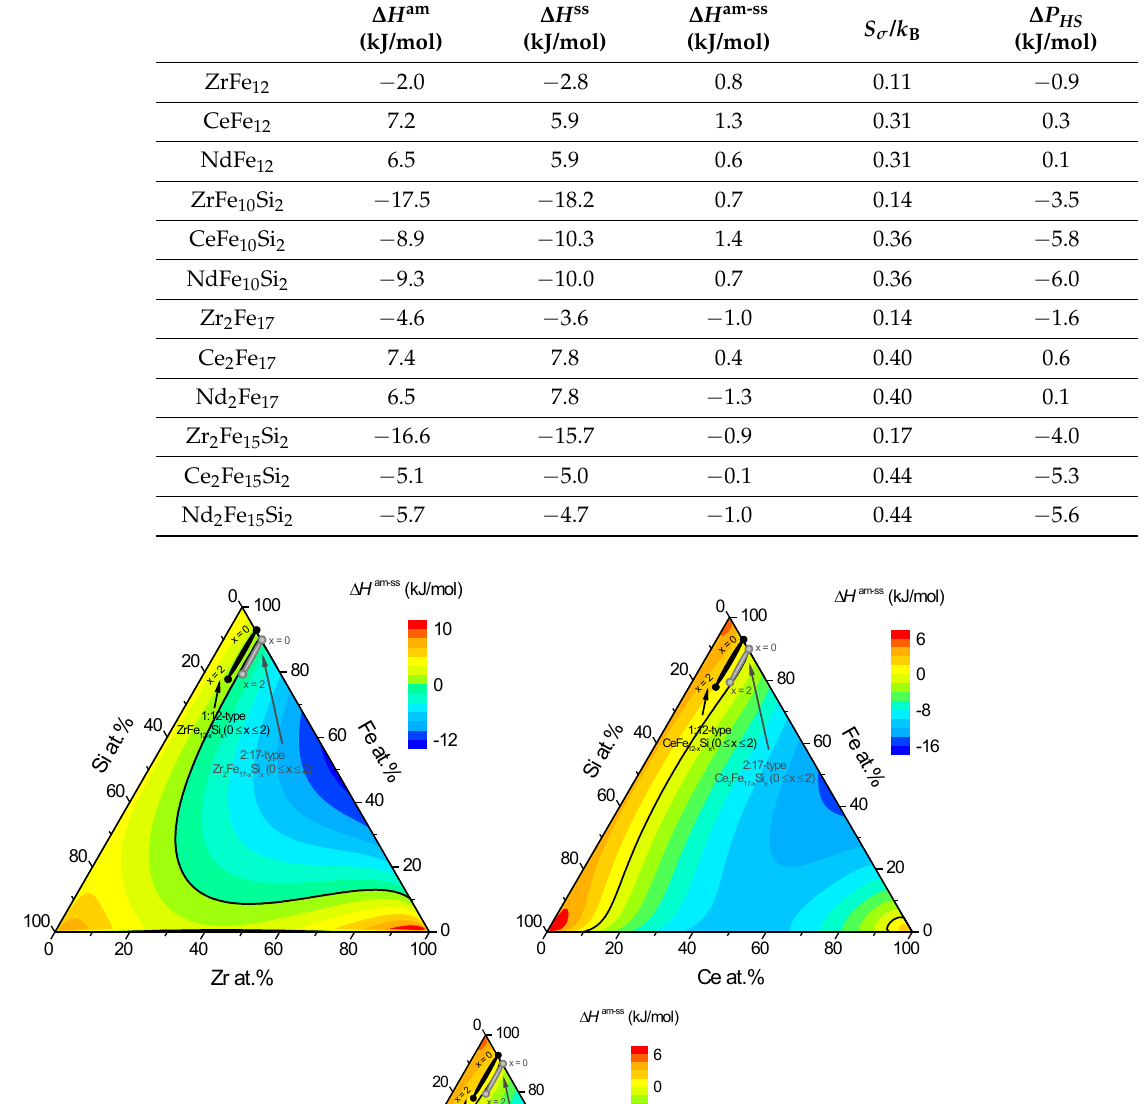
, of solid solution , their dif- 𝑒𝑒𝑒𝑒 𝑤𝑤𝑤𝑤 ∆𝐻𝐻 ∆𝐻𝐻